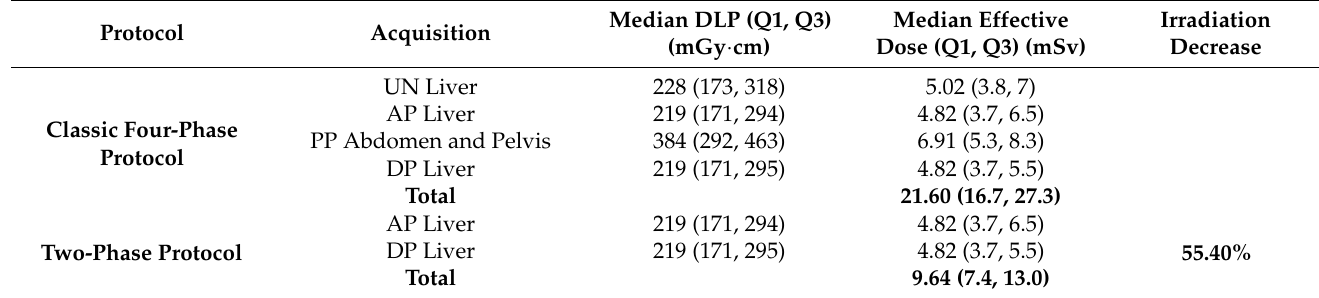
Table 3. The X-ray dosimetry according to the four-phase and two-phase MDCT